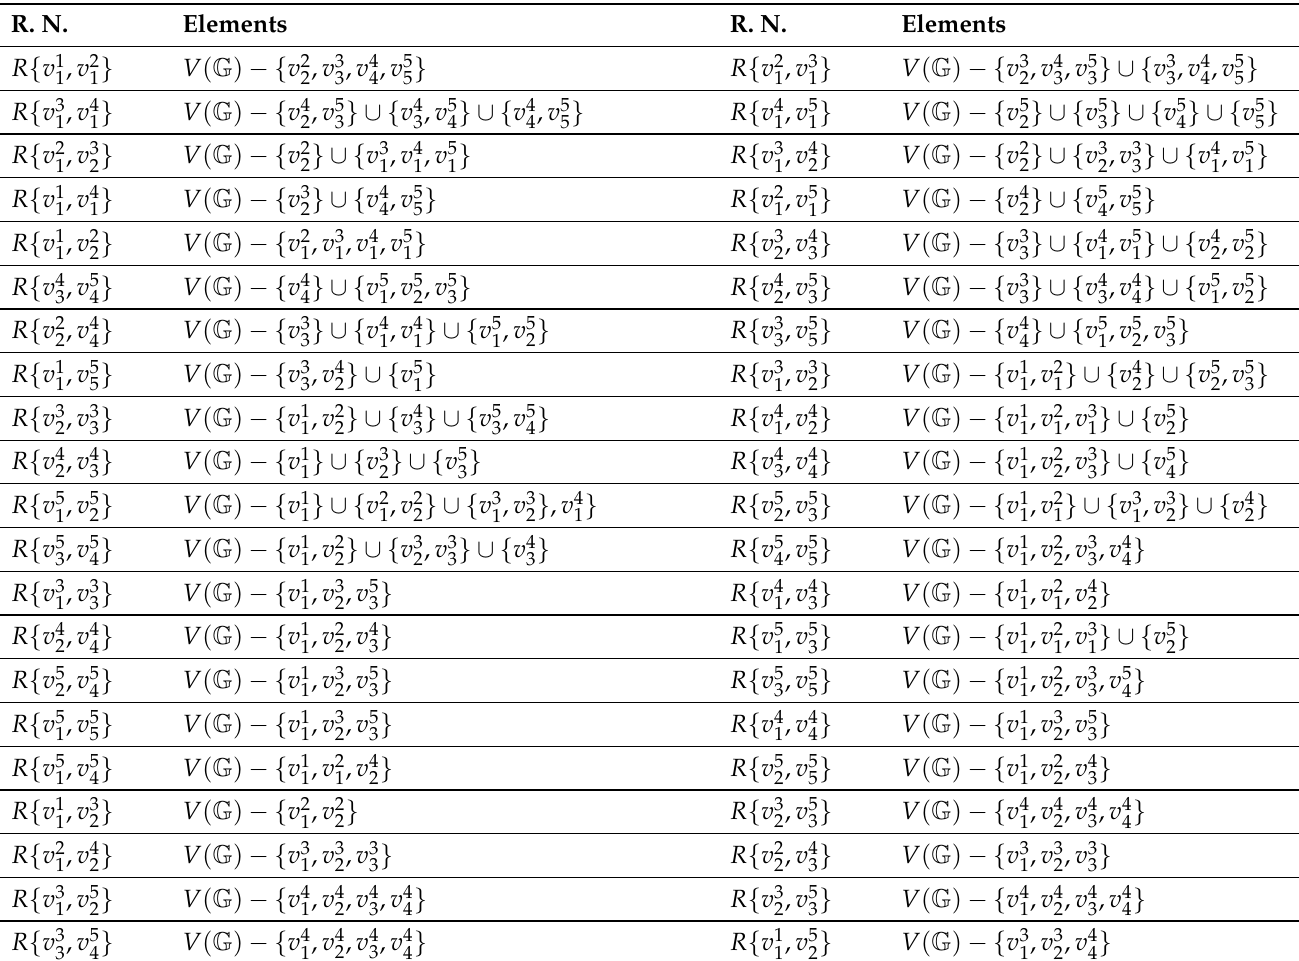
Table 8. ´ R u for 1 ≤ u ≤